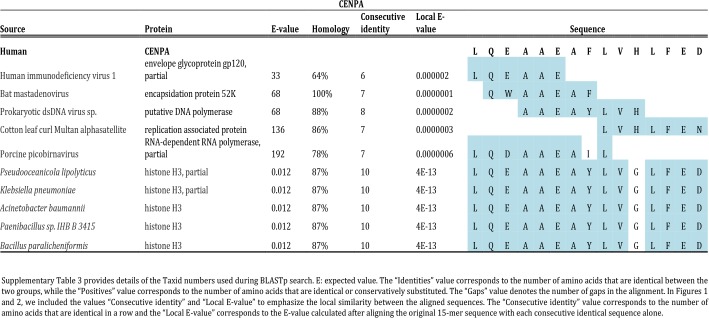
Representative microbial and viral mimics of centromere A (CENPA) dominant autoepitope.For each sequence (i.e. the 15-mer of and the 15-mer of CENPA), the first five-homology pairs with viruses and the first five-homology pairs with bacteria were chosen, according to the following criteria:- The pairs ought to have at least 6 (≥6) consecutive homologous aa, allowing one aa difference, but of the same side chain group (i.e. I➔V or Y➔F)- Only one pair was chosen from same species- No pairs from phages were included- No pairs from uncultured bacteria or viruses were included- No hypothetical proteins were included